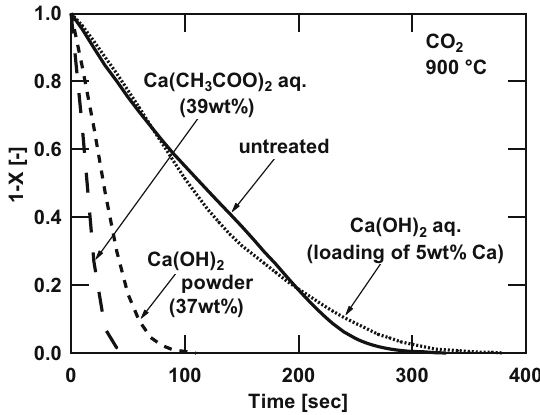
Figure 8: CO 2 gasi fi cation pro fi les at 900°C for some kinds of Ca - loaded grounds ’ chars.